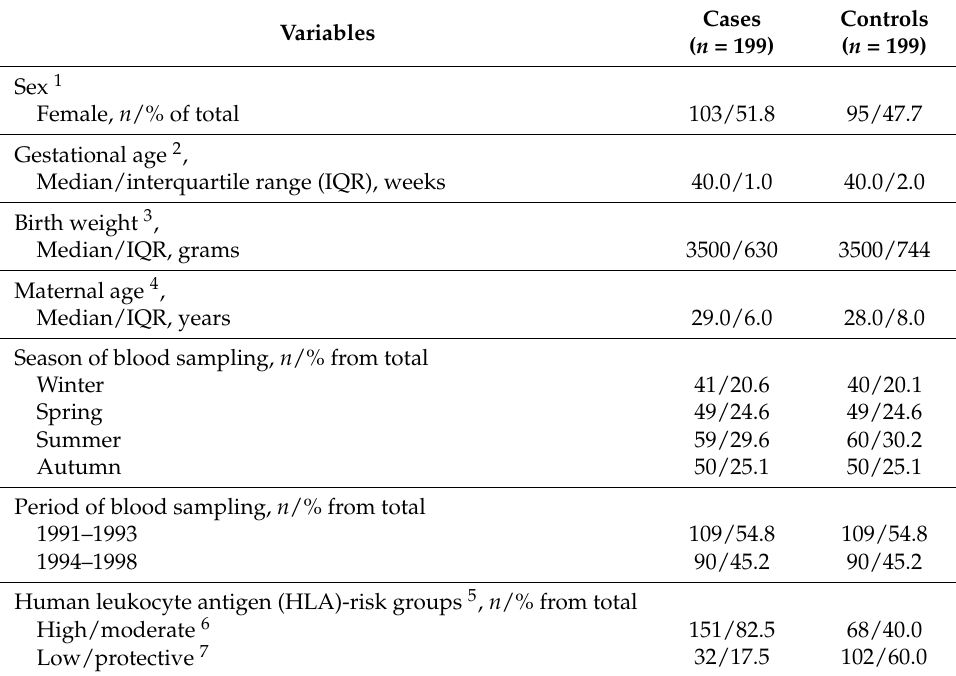
Table 1. Characteristics of the study sample (including specification of missing